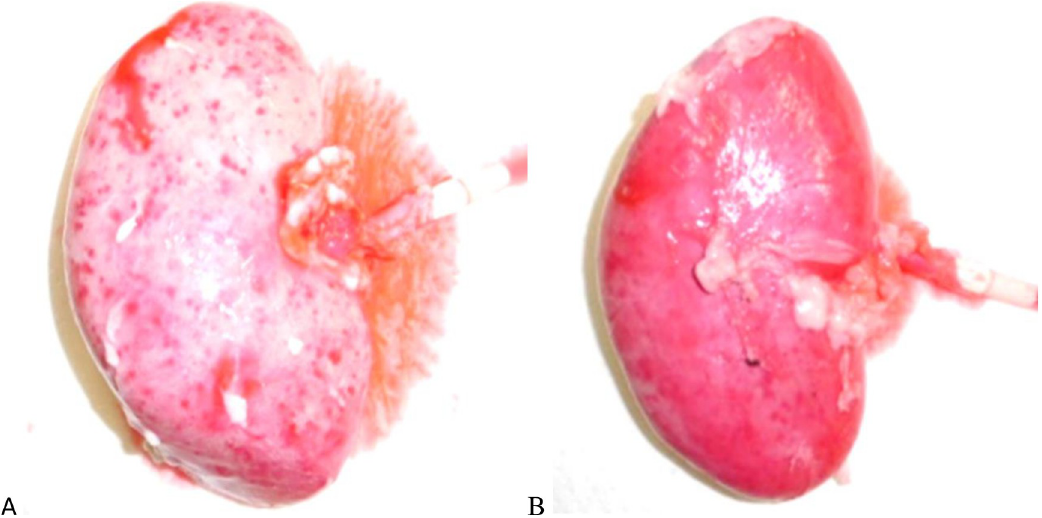
Fig 6. Evaluation of surgery to use blood-like fluids return. (A) Immediately after the infusion of blood-like fluids, the kidney became discolored in diffuse spots. (B) In about 5 minutes, the kidneys were uniformly discolored.